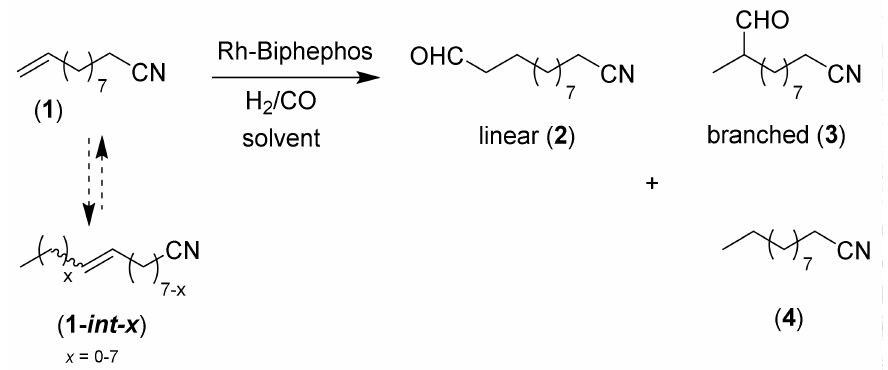
Figure 1. Illustration of the main products obtained from the Rh-catalyzed hydroformylation of 10-undecenitrile ( 1